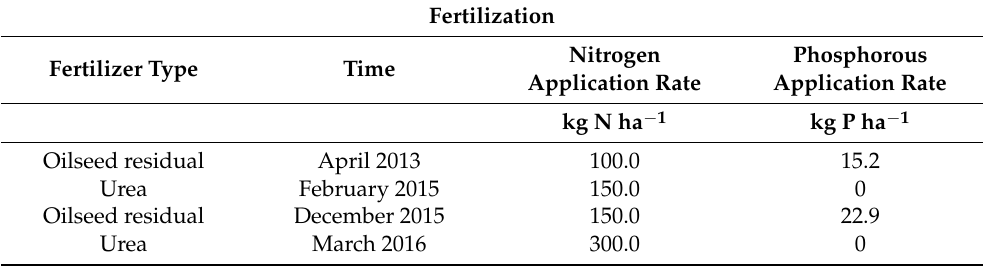
Table 1. Fertilization in the tea system during the observation